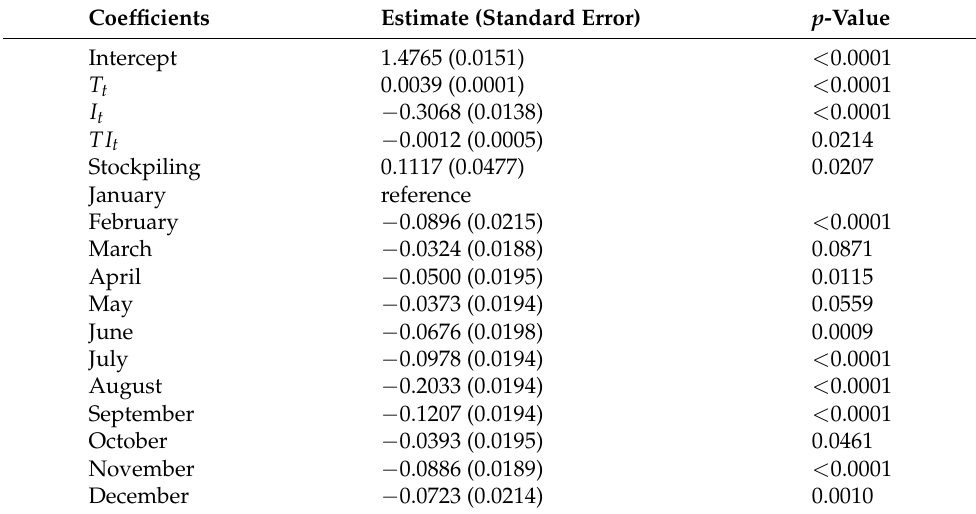
Table 4. Results of the segmented linear regression model for real